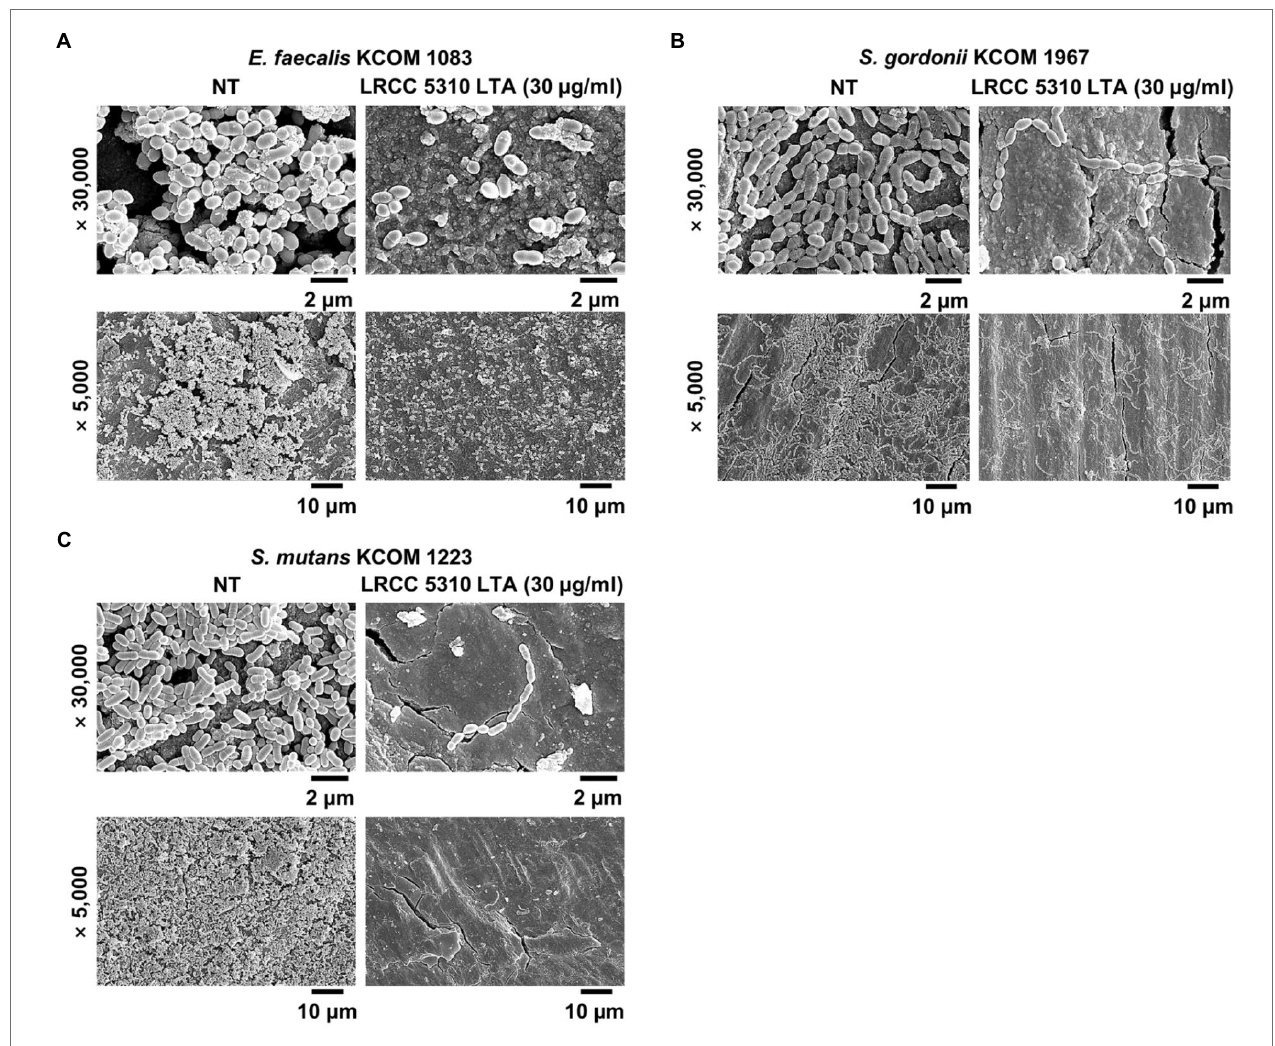
FIGURE 6 | LRCC 5310 Lp.LTA suppresses biofilm formation of clinically isolated dental pathogens on human dentin slices. Clinically isolated strains of (A) E. faecalis (KCOM 1083), (B) S. gordonii (KCOM 1967), and (C) S. mutans (KCOM 1223) at 1 × 10 7 CFU/ml was grown on human dentin slices in the presence or absence of 30 μ g/ml of LRCC 5310 Lp.LTA at 37 ° C for 24 h. Images were obtained by scanning electron microscopy with magnification at ×5,000 and ×30,000. Scale bars given in each image indicate 2 or 10 μ